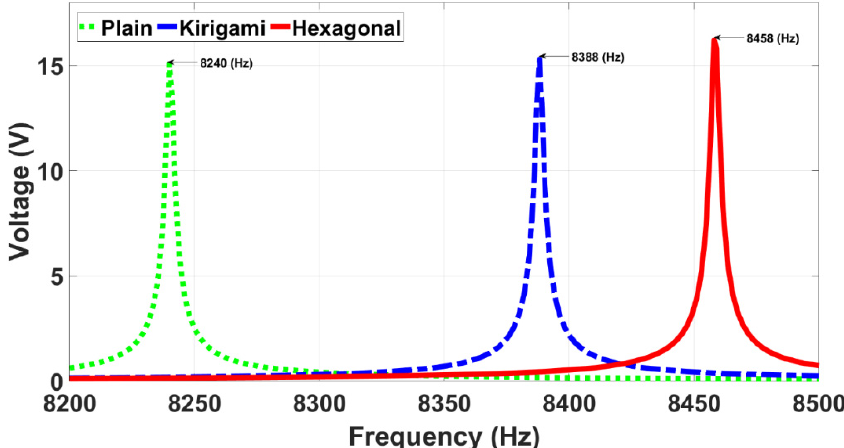
Figure 8. Simulated voltage output against frequency. All points use the same excitation of 5 Pa.